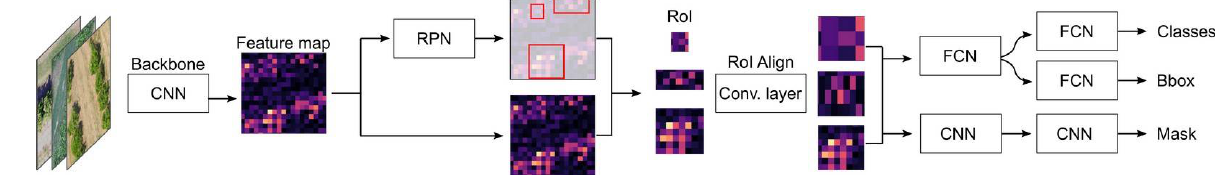
Figure 3. Mask R-CNN Architecture.